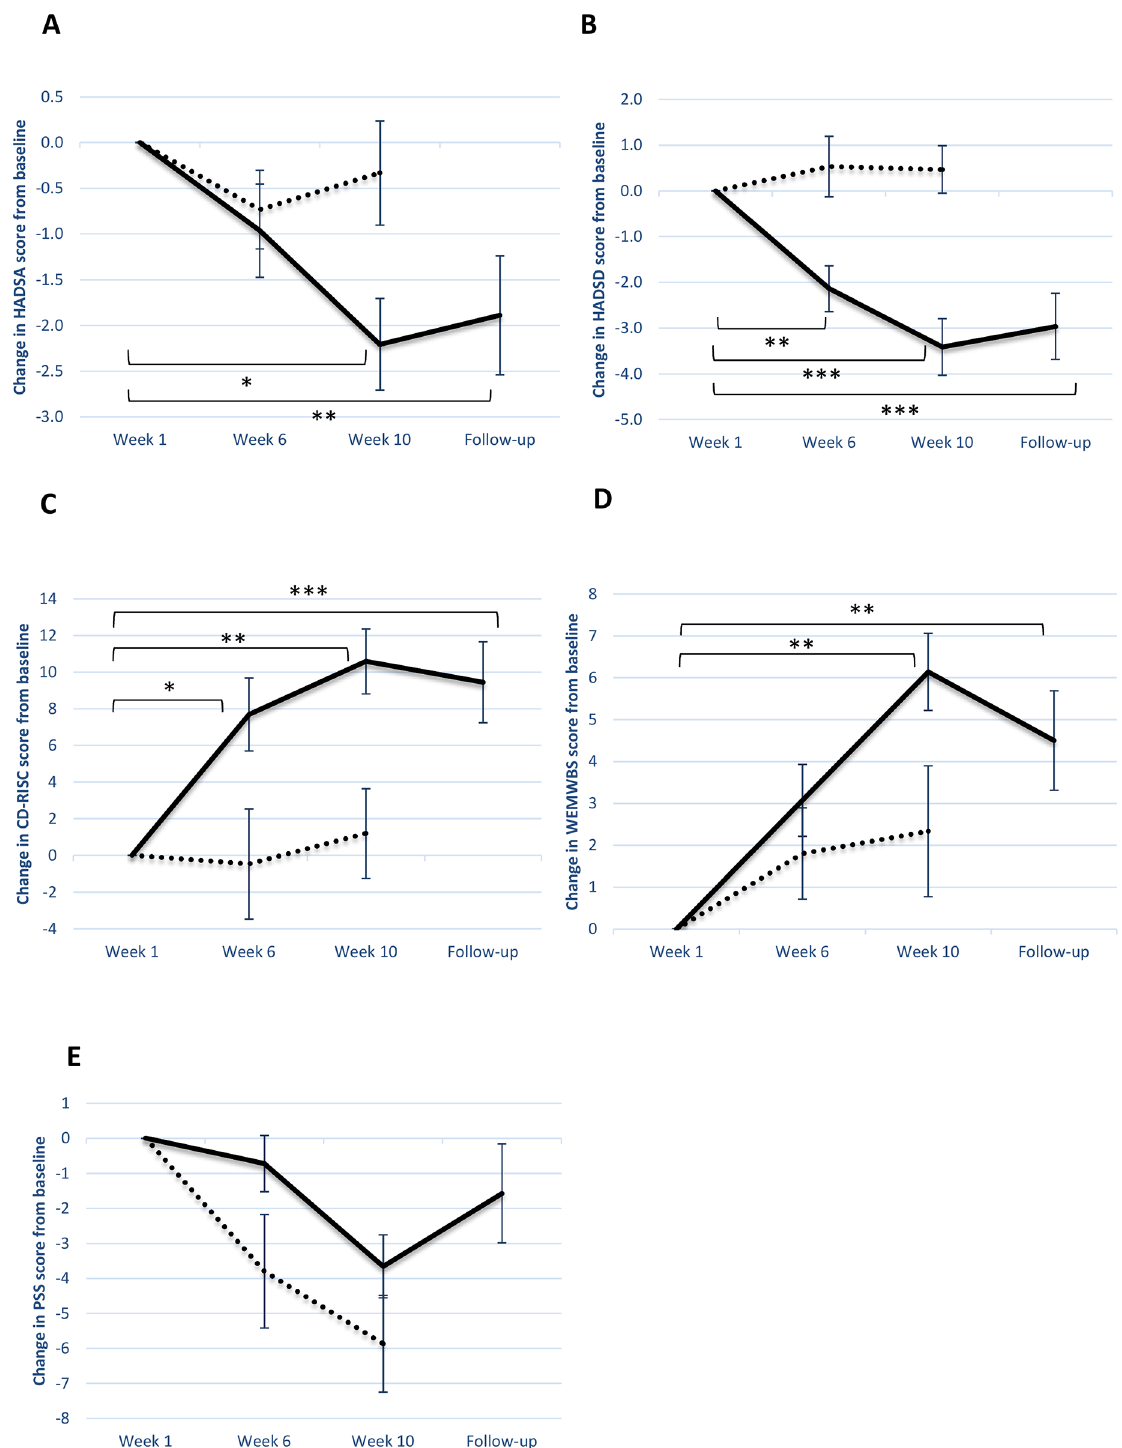
Fig 2. Psychological results. Within-subject change from baseline (with standard error) at weeks 6 and10 for drumming and controlgroups for (A) Anxiety (HADSA), (B) Depression (HADSD)(C) Social Resilience (CDRISC), (D) MentalWellbeing (WEMWBS) (E) and Perceived Stress (PSS). * = p < .05, ** = p < .01, *** = p <